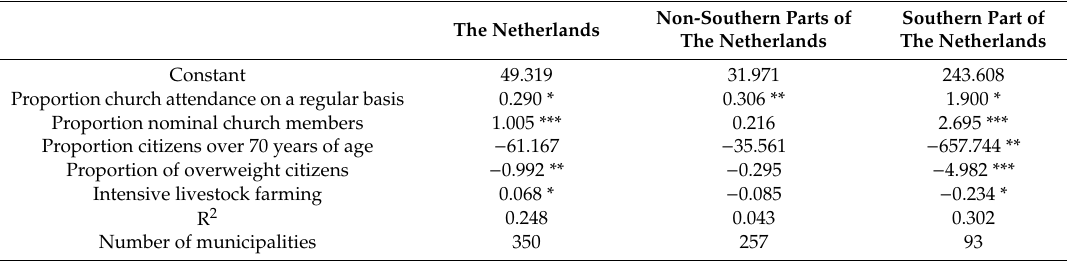
Table A2. Linear regression analyses (B’s) of reported deaths due to COVID-19 per 100,000 residents (March 2–May